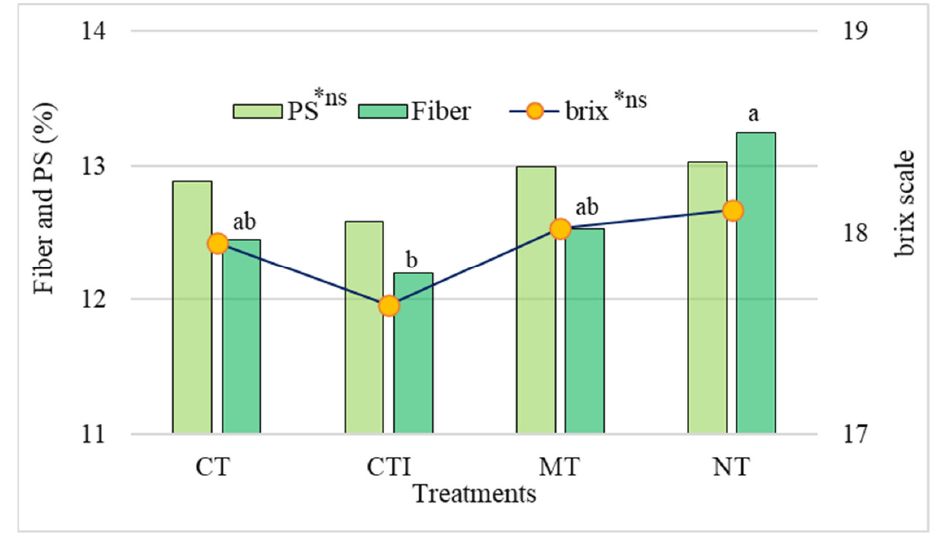
Figure 5. Sugarcane chemical variables (fresh matter) evaluation of fiber content (Fiber), polymer- izable sugar (PS), and Brix, as a function of treatments: NT, MT, CT and CTI. Means followed by the same letter do not differ by Tukey ʹ s test, at 5% significance. *ns indicates no difference between means.